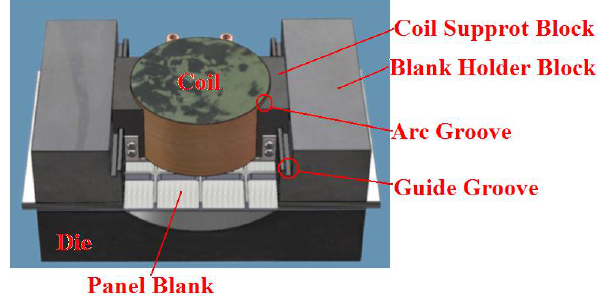
Figure 3. Forming equipment during electromagnetic incremental forming (EMIF) of stiffened panels.